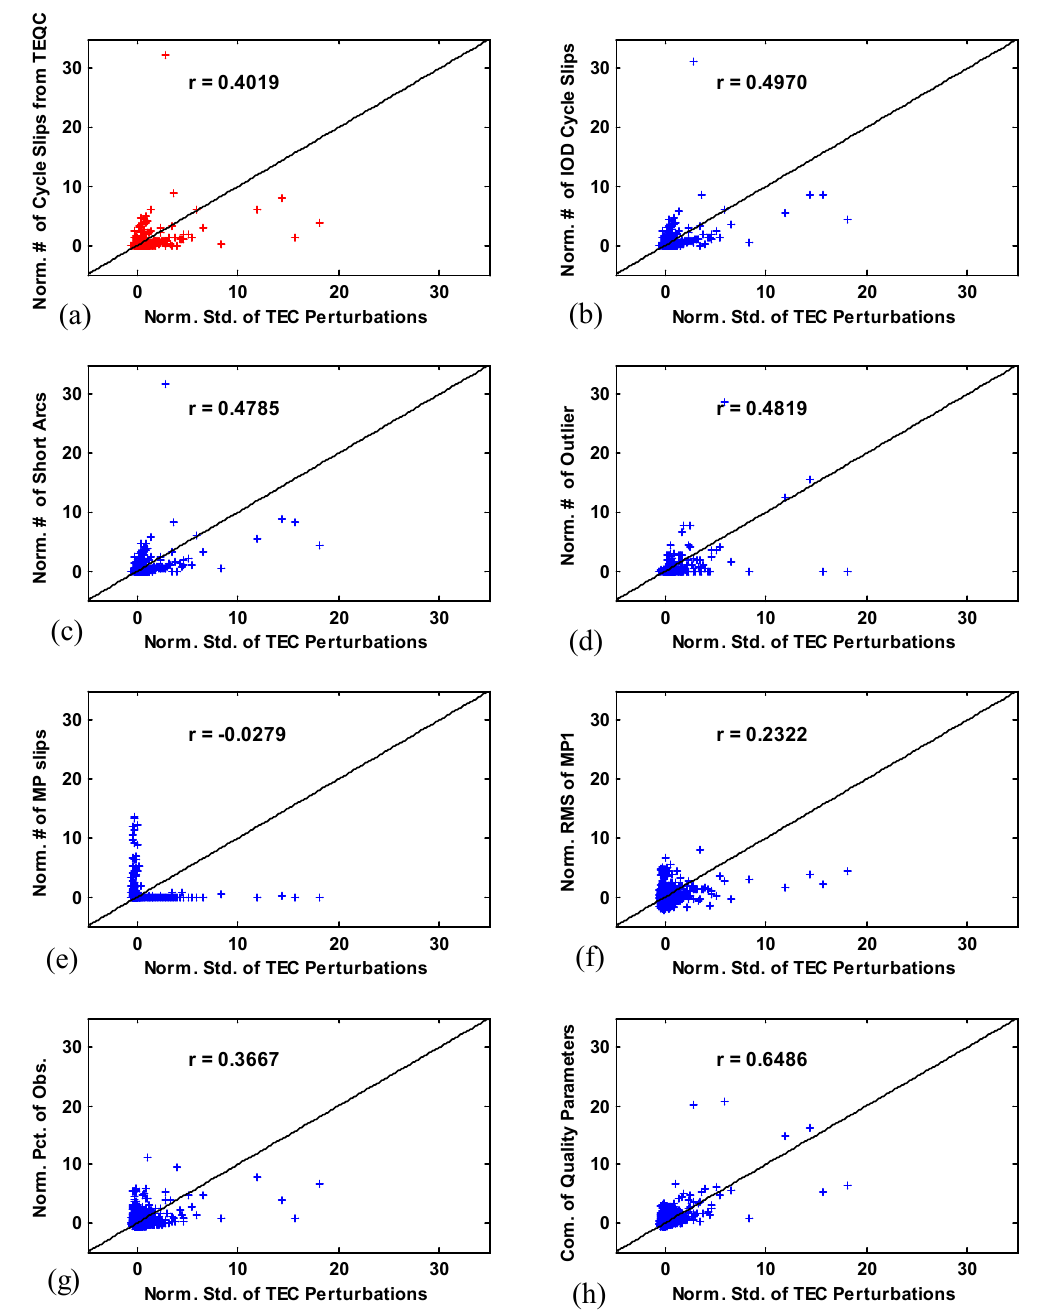
Figure 10. Correlation of TEC perturbation with data quality parameters for CORS stations (all parameters are normalized): ( a ) number of IOD cycle slips obtained from TEQC; ( b ) number of IOD cycle slips; ( c ) number of short arcs; ( d ) number of outliers; ( e ) number of MP slips; ( f ) RMS of MP1; ( g ) percentage of observations; and ( h ) combination of three quality